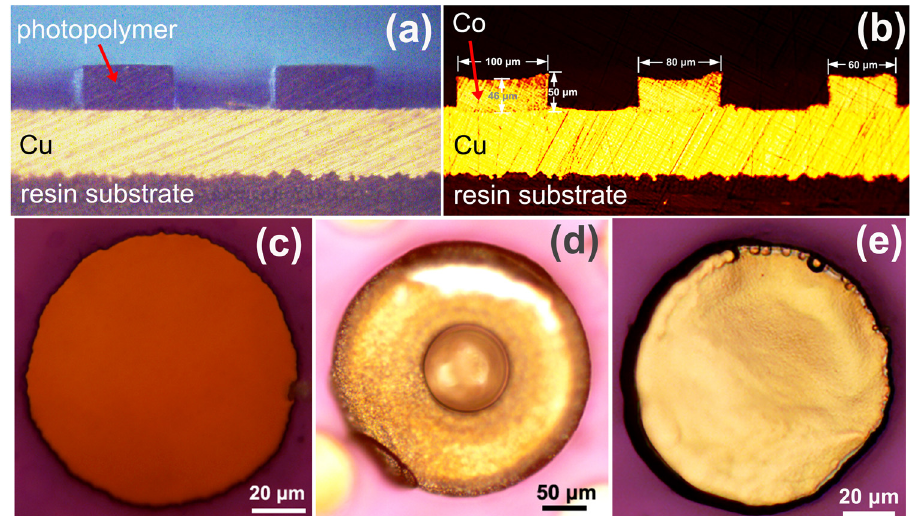
Figure 6: Cross - sectional slice of the holes before electrodeposition ( a ) and the electrodeposited cobalt - fi lled holes ( b ) . Top view of the holes before cobalt electrodeposition ( c ) . Top view of the hole after cobalt electrodeposition in solution without additives ( d ) and with 7 mg/L MPS and 300 mg/L PVP ( e )